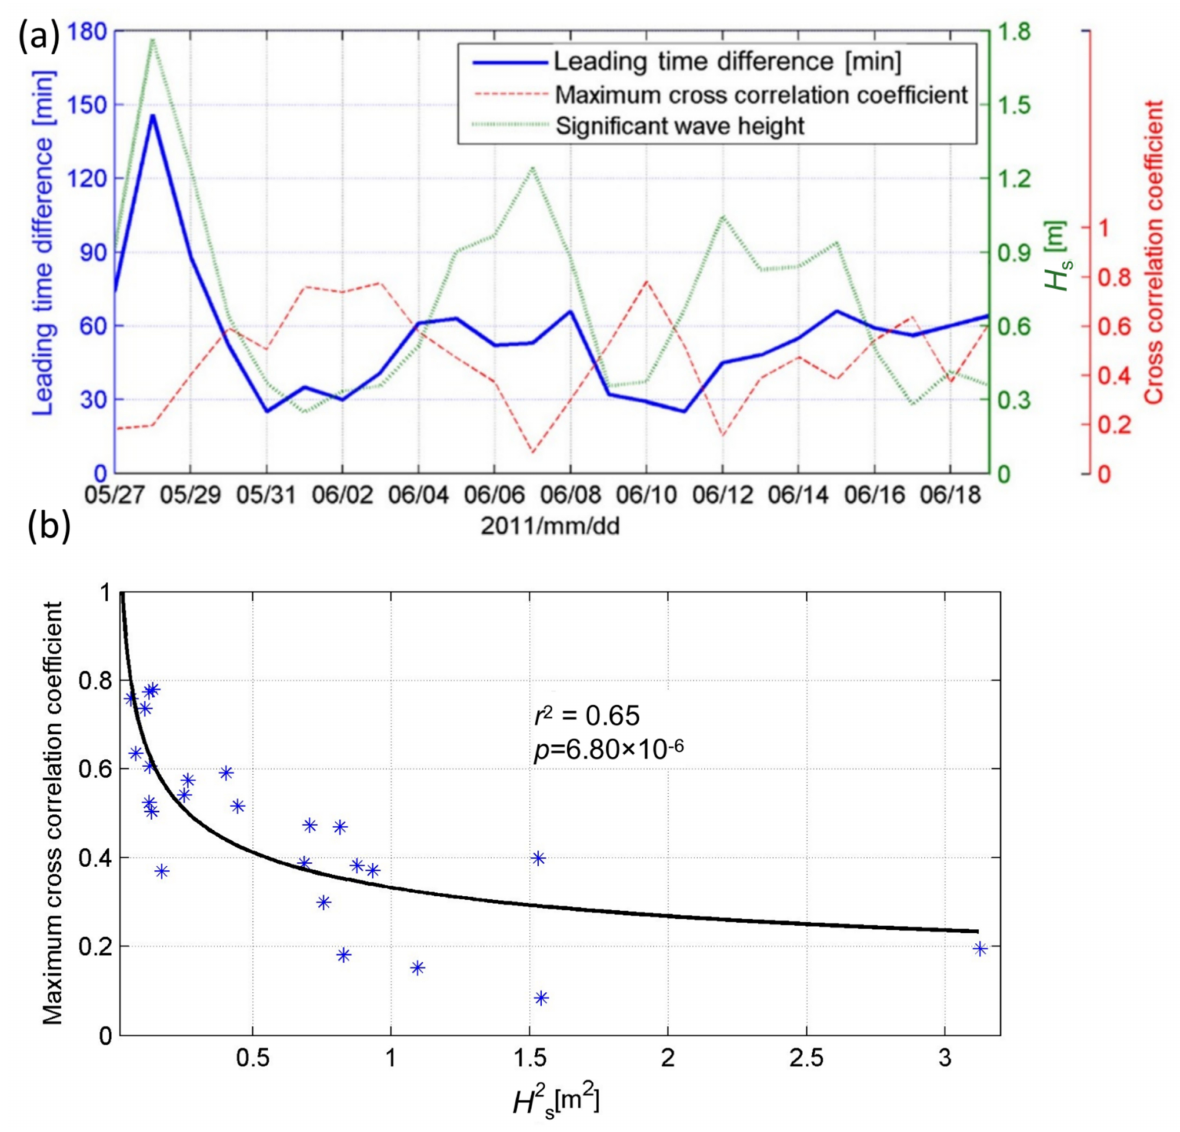
Figure 11. ( a ) The leading time difference (solid blue line) between the phase of currents measured by ADCP (~1000 m offshore) and the phase measured by the Zhuwei tide gauge (nearshore), their maximum cross-correlation coefficient (red dashed line), and H s measured by ADCP (green dotted line) versus time. ( b ) The maximum cross-correlation coefficient versus H s 2 , where the blue asterisks are the observations, and the black line is an exponential fit line with squared correlation coefficient, r 2 , and p value shown on the